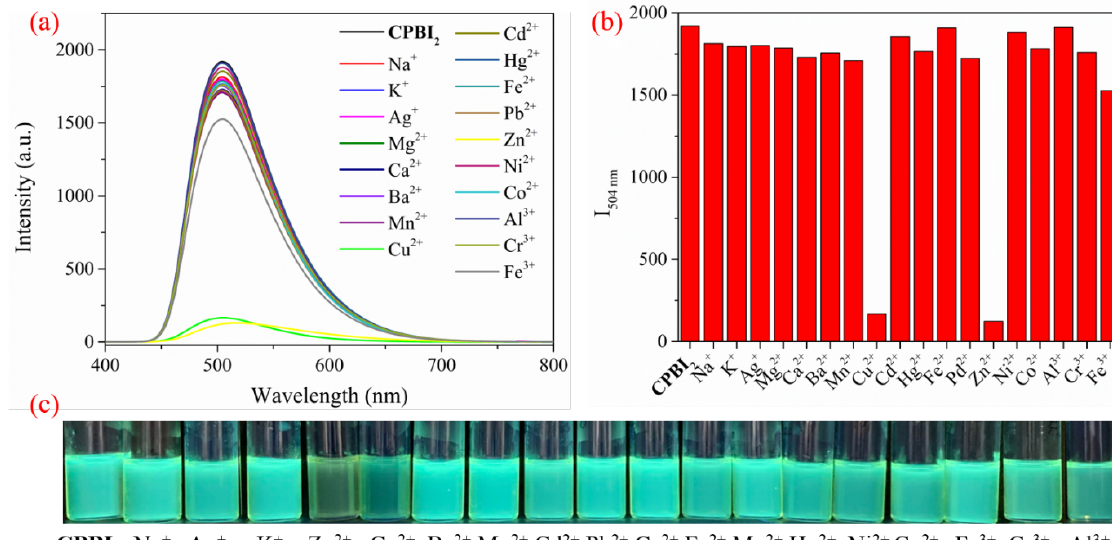
Figure 4. The fluorescence selectivity study of different metal ions (100 μM) in CPBI 2 (1 mg/15 mL in DMSO/H 2 O, v / v , 9/1) solution, λ ex = 375 nm ( a ); the influence of adding different metal ions (100 μM) on CPBI 2 fluorescence intensity at 504 nm ( b ); and the fluorescence color change of the solution when different metal ions are added under a 365 nm UV lamp ( c ).